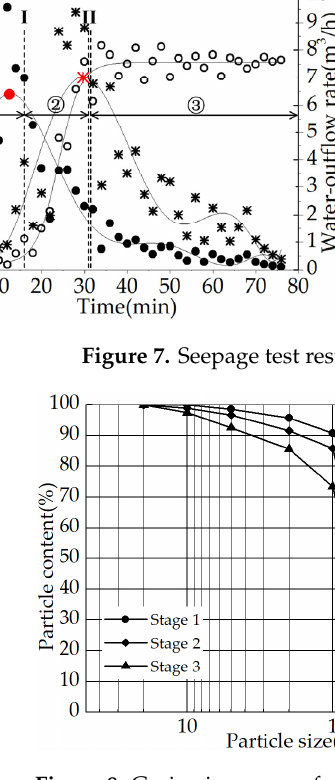
Figure 8. Grain-size curve of eroded soil particles.